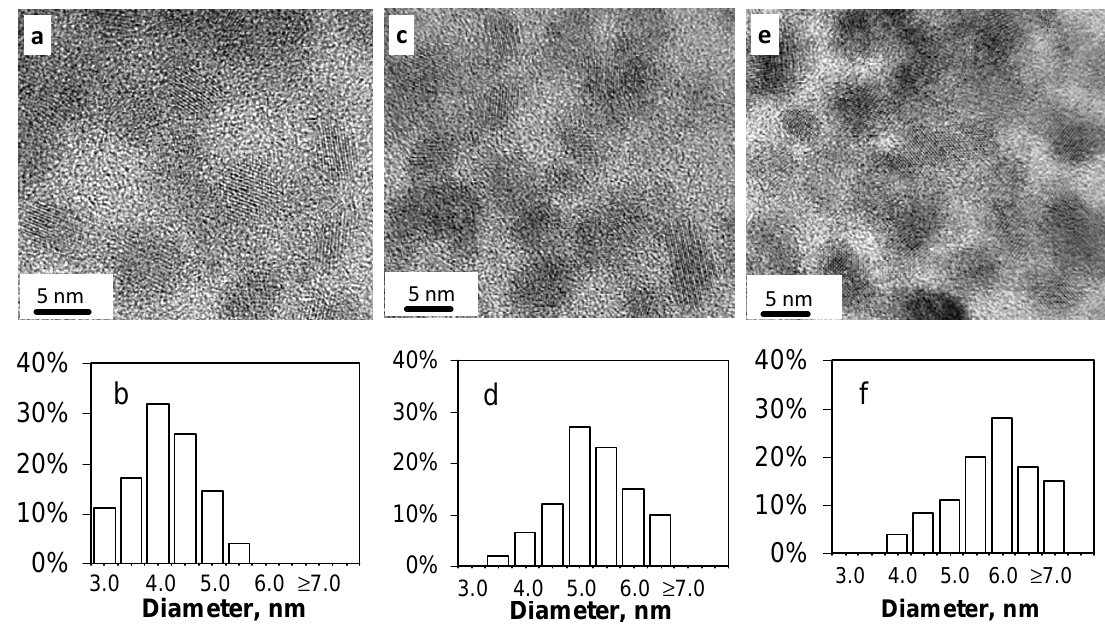
Figure 8. Reflectance spectra (normalised) of SnS nanoparticle films that cast from particles made in the presence of 6 mL TEA at different heating time. Inset: The first derivative of film reflectance versus incident photon